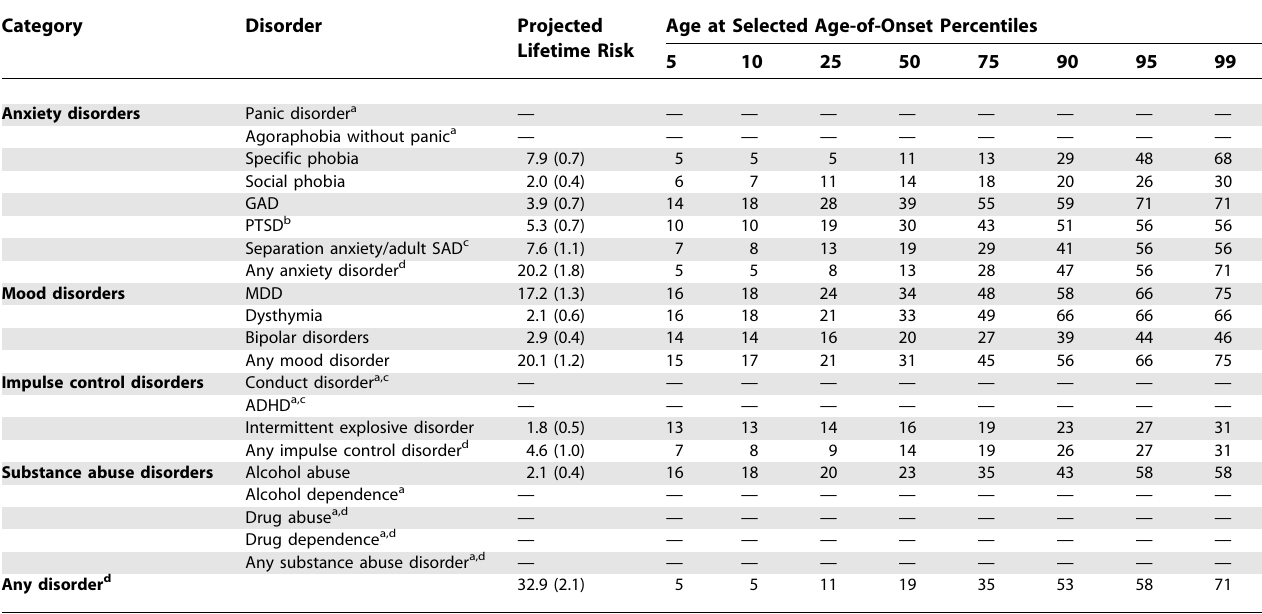
Table 2. Ages at Selected Percentiles on the Standardized Age-of-Onset Distributions of Disorders with Projected Lifetime Risk at 75 y Category Disorder Projected Lifetime Risk Anxiety disorders Panic disorder